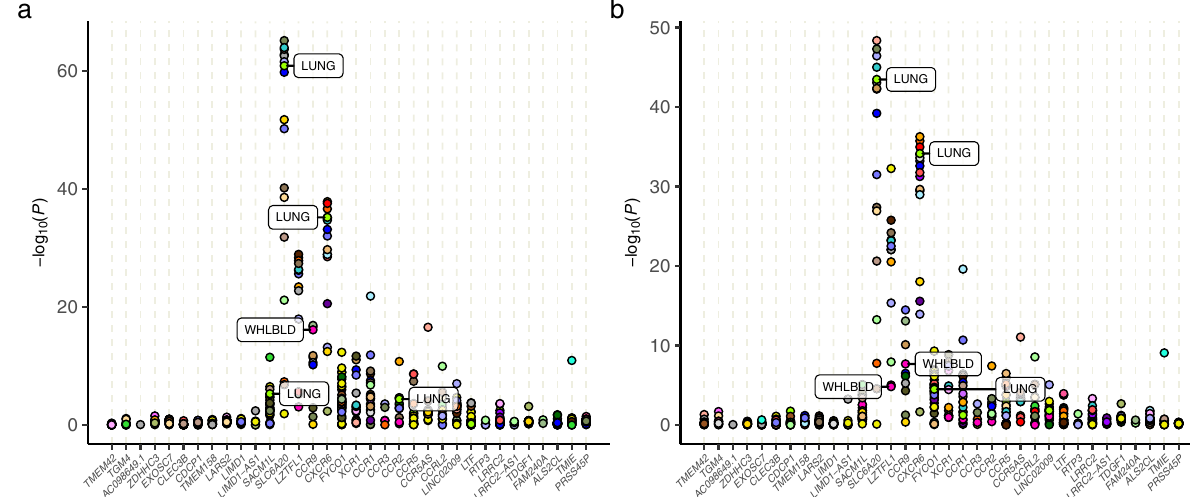
Fig. 3 Region-level association test. Region-level association analysis of COVID-19 hospitalization ( a ) and severity ( b ) was performed on the GWAS summary statistics from COVID-19 HGI round 6. To maximize the power of the association test, we used the full model (i.e., analyzed all local variants around each gene; “ Methods ” ) trained using JTI. The association results for the genes within 1 Mb of the introgressed segment are included in the region-level plot. Signi fi cant ( P FDR < 0.05) results observed in lung (LUNG) or in whole blood (WHLBLD) are labeled with tissue abbreviations. The positions of the genes on the x -axis do not represent their physical locations in the genome. (See Fig. 2a for their relative chromosomal positions.) The association results are summarized in Supplementary Table